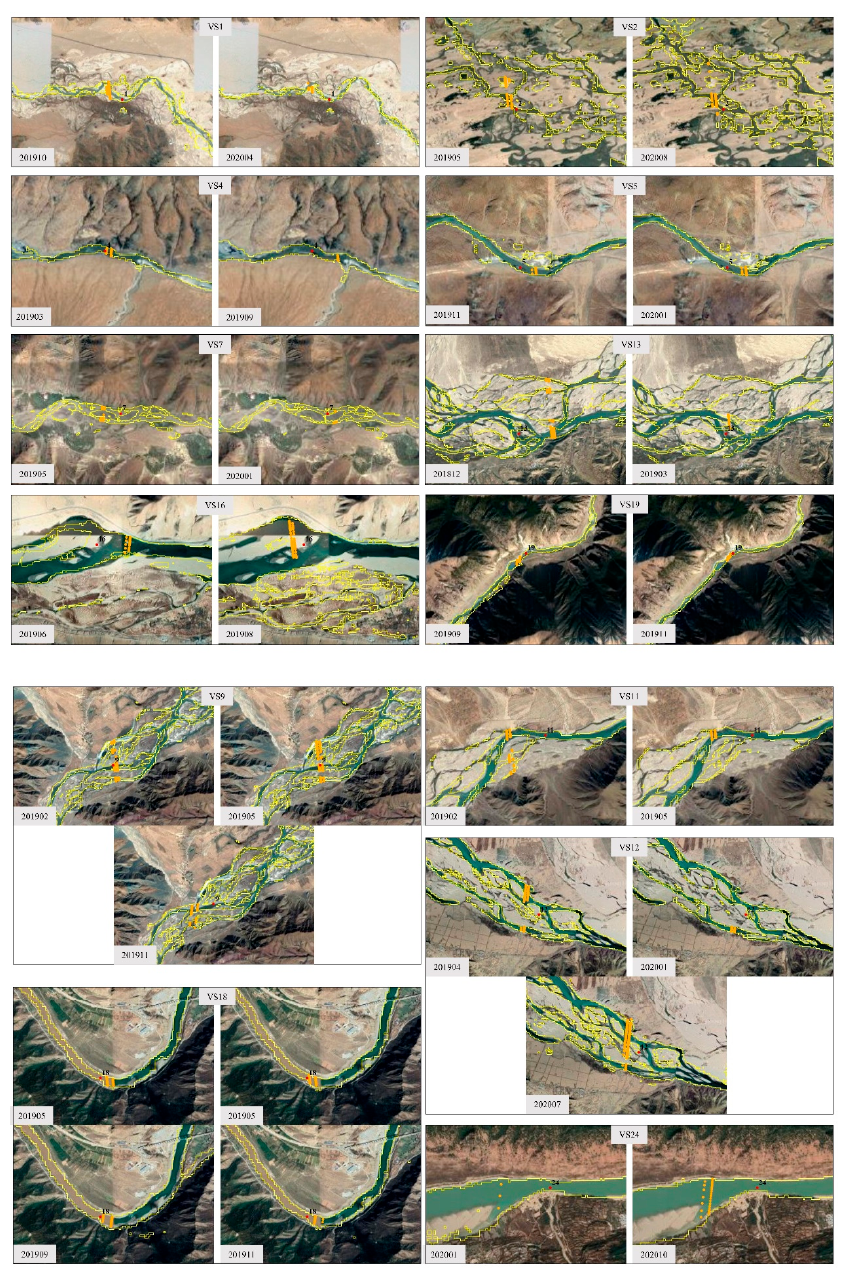
Figure 7. Locations of the Hydroweb virtual stations and adjacent ICESat-2 tracks.